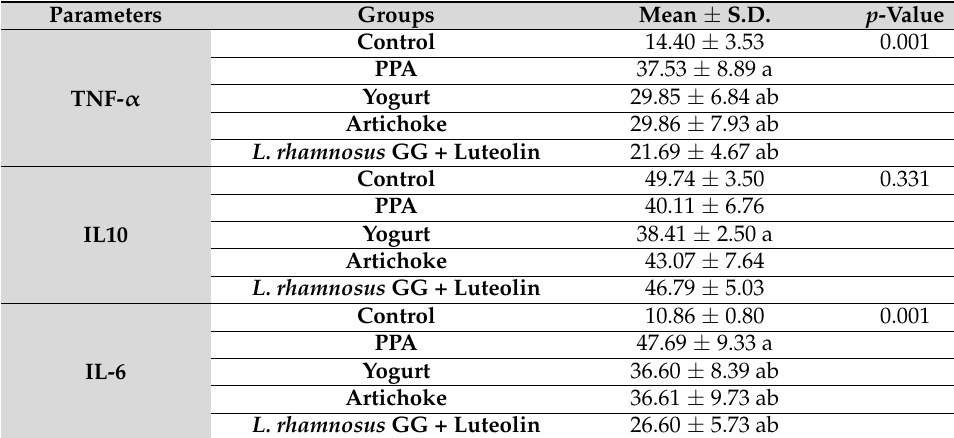
Table 2. Effect of nutrition with yogurt, artichokes, and combined L. rhamnosus GG + luteolin on levels of TNF- α (pg/mg protein), IL10 (pg/mg protein), and IL-6 (pg/mg protein) in the brain homogenates of the PPA-induced rodent model of autism.